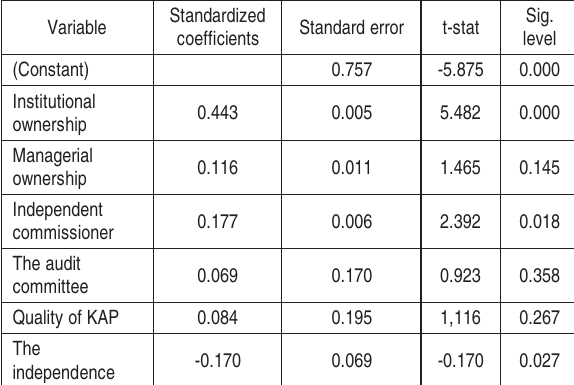
Table 3. Results of regression